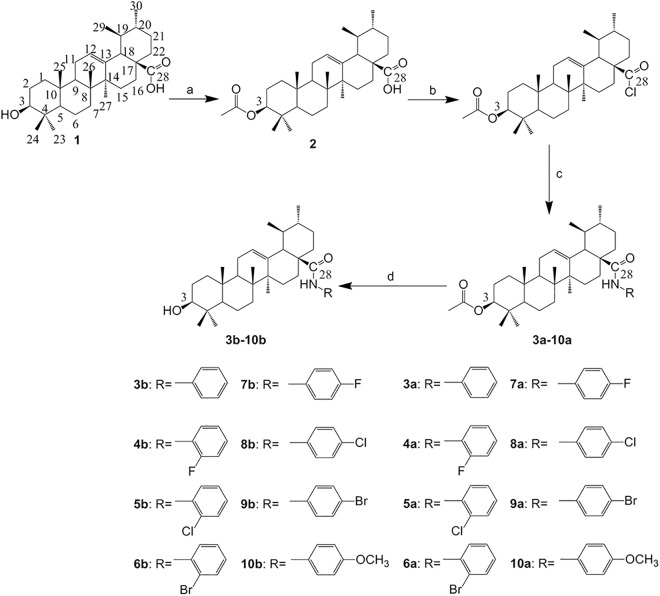
Synthesis of analogues 10a, 3b-10b from UA.Reagents and conditions: (a) acetic anhydride/Pyr/DMAP, r.t.; (b) (COCl)2, CH2Cl2, r.t.; (c) CH2Cl2, Et3N, R-NH2, r.t.; (d) NaOH, THF/CH3OH, r.t.